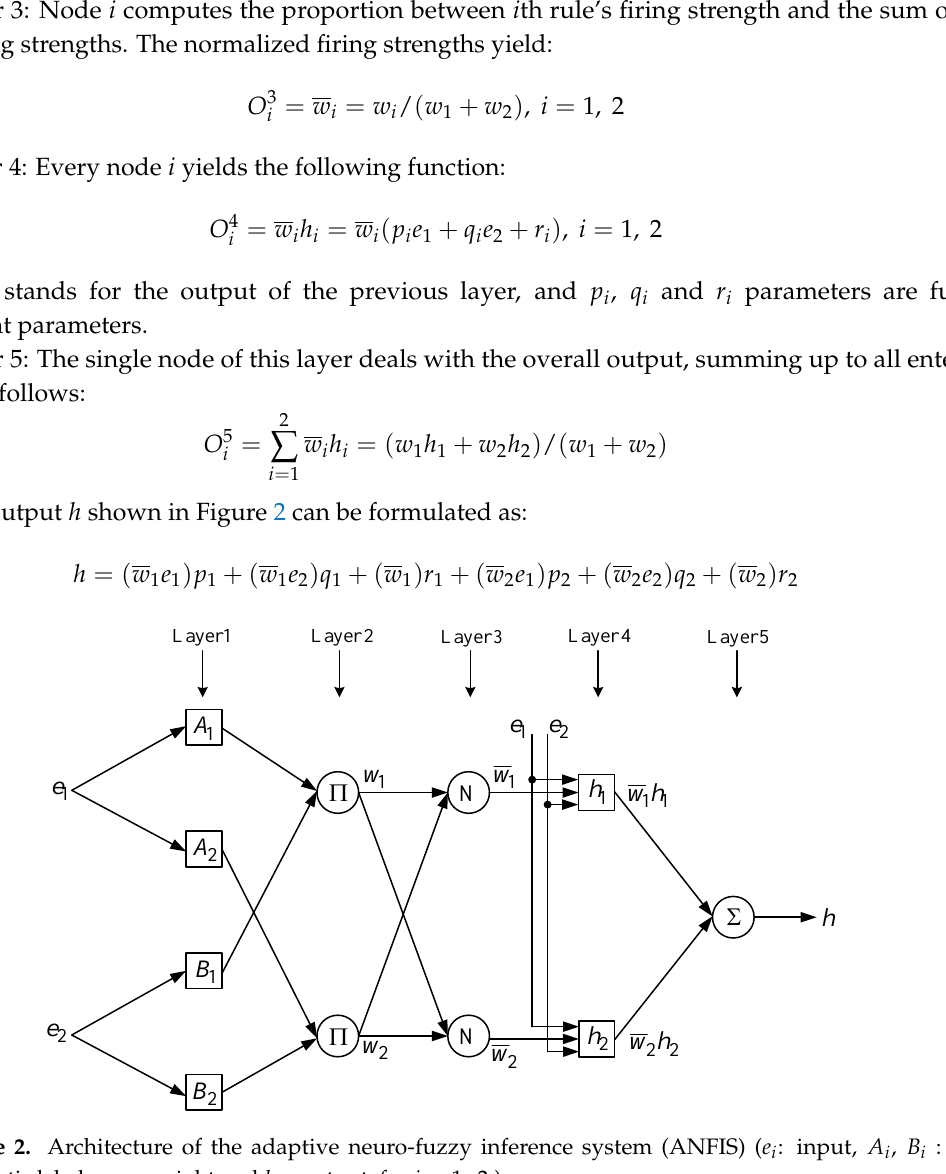
Table 1. VSI system